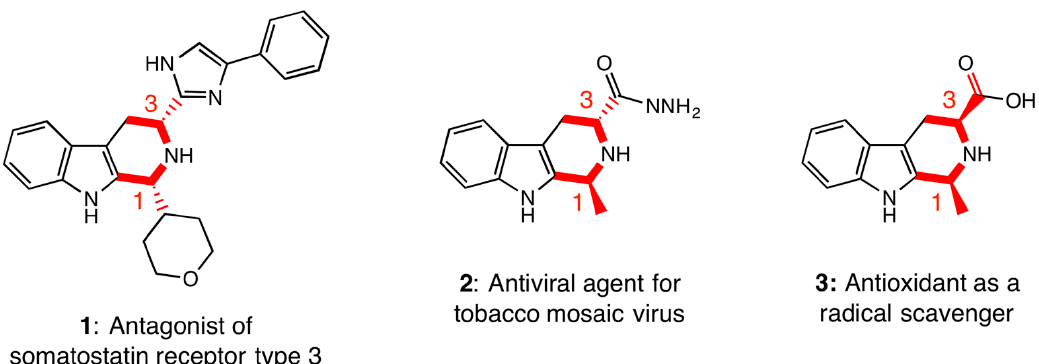
Figure 1. Representative bioactive compounds with 1,3-disubstituted tryptoline derivatives.